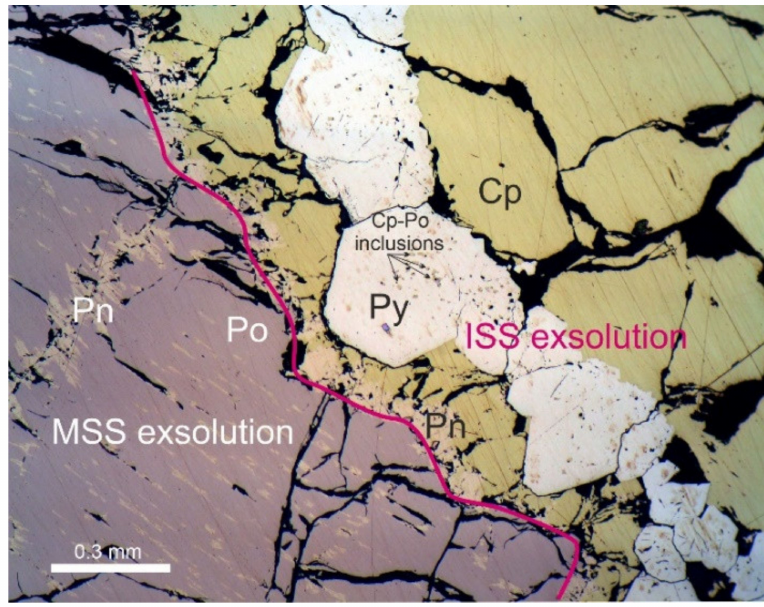
Figure 15. Contact between MSS (Po + Pn) and ISS (Cp + Py + Pn)